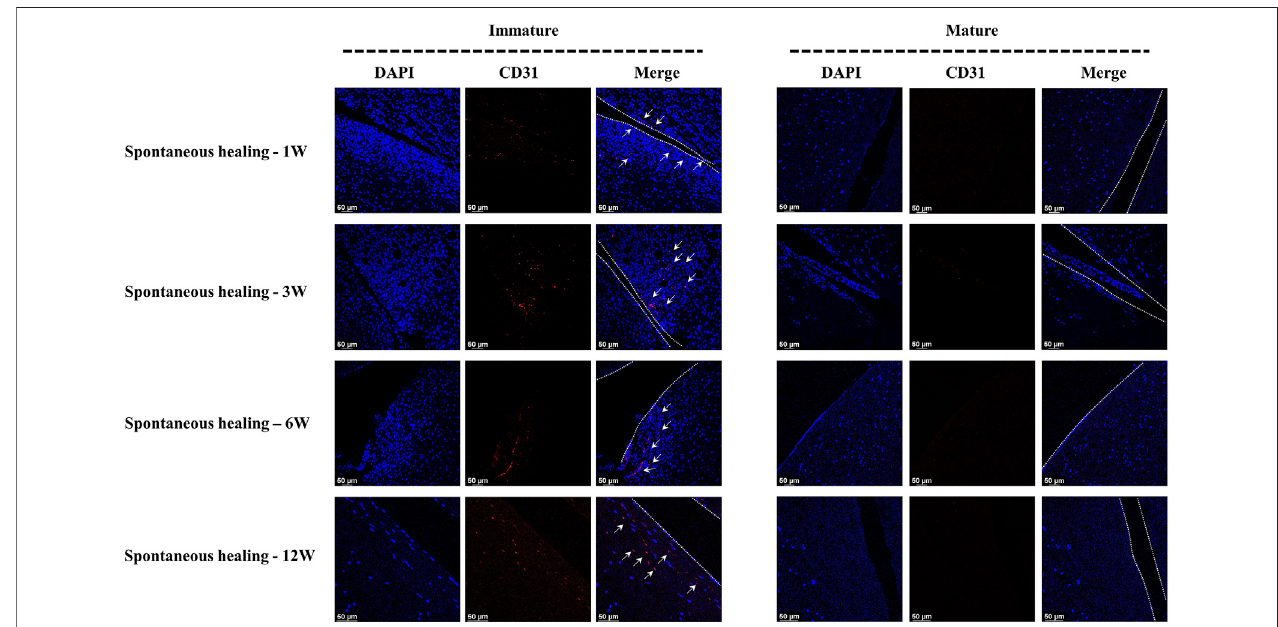
FIGURE 5 | The assessment of vascularization in immature and mature menisci after untreated meniscal tears. The white arrows indicate CD31 positive cells. The dotted white lines indicate tear edges.